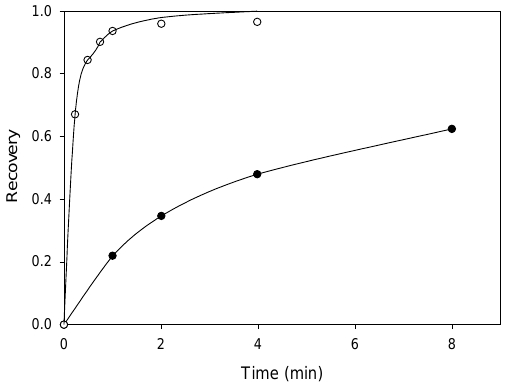
Figure 15. Recovery of chalcopyrite vs. flotation time without collector (black points) and 100 g/t PAX (white points). The pulp was kept at pH 9 with KOH and through an airflow of 10 mL min − 1 . The particles were conditioned for 5 min before introducing the air into the column (adapted from Vizcarra et al. [46]).